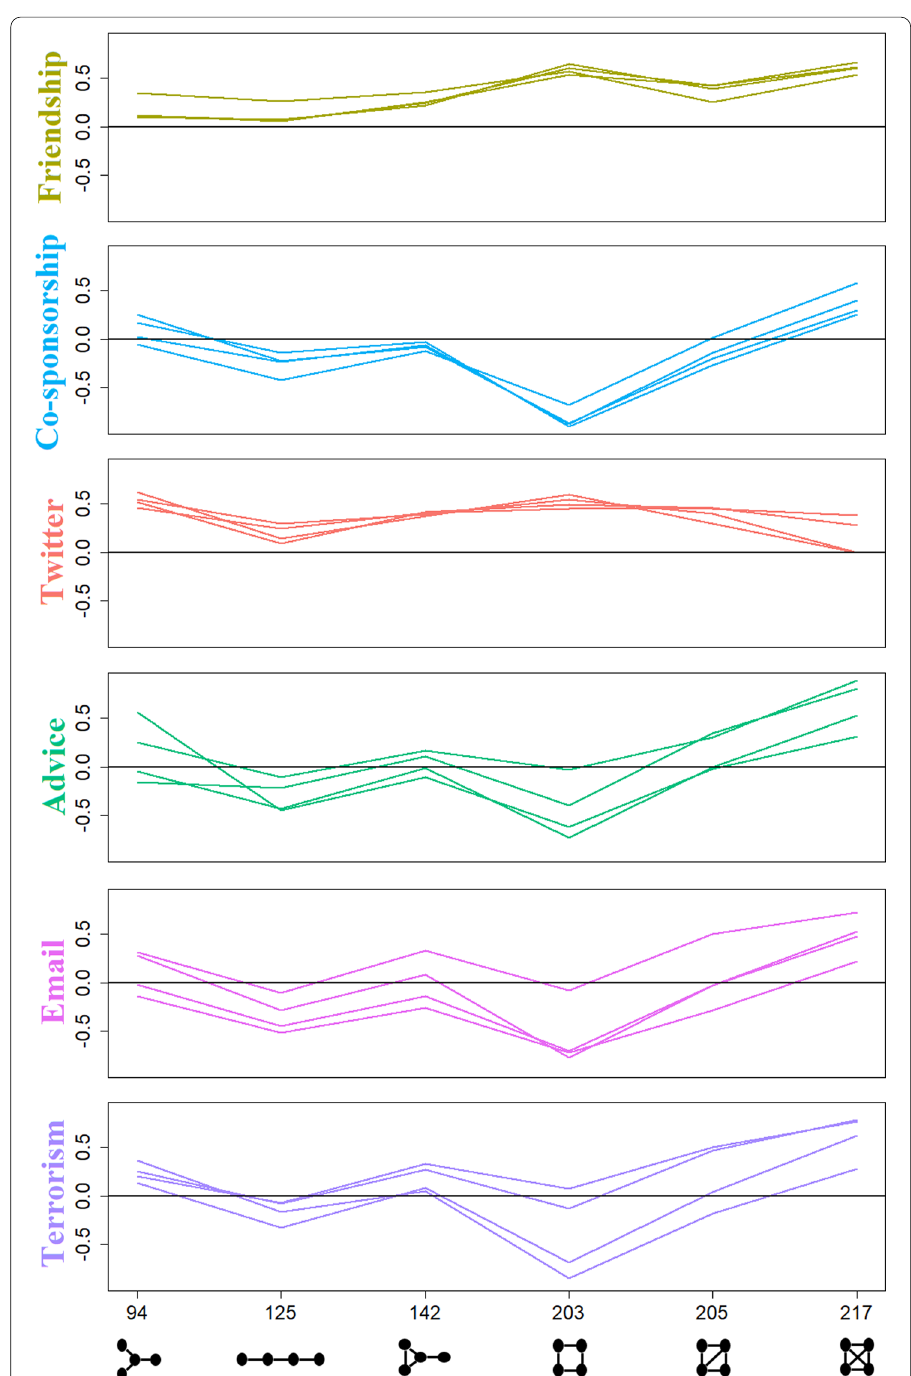
Fig. 6 Significance profiles for symmetric tetrads by network type. Range of y -axes refer to SRP i for tetrad of